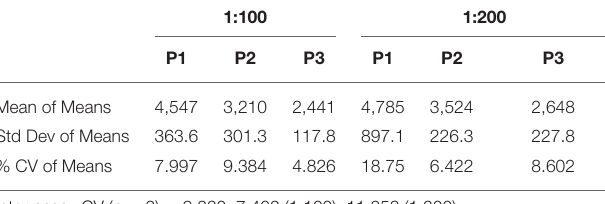
FIGURE 2 | Specificity of the C3(H 2 O) ELISA. (A) Binding comparison of proteins using anti-C3 pAb for detection . (B) Specificity of ELISA employing anti-C3a pAb. C3(MA) and iC3(MA) are detected. (C) Schematic depicting the cleavage and inactivation of C3(H 2 O) by cofactor proteins and the serine protease FI. Adapted from Elvington et al. ( 20). (D) Increasing concentrations of C3(MA) were spiked into 1:100 NHS which had a baseline C3(H 2 O) level of 938ng/ml and protein recovery of the C3(MA) over baseline was assessed by ELISA; n = 2, representative of 2 independent experiments. (E) C3(H 2 O) was measured in human serum and plasma from healthy adults; n = 3 donors (in duplicate, intra-assay precision; %CV 4.97). (F) Increasing quantity of purified C3b (red) or iC3b (blue) was incubated with 40ng/ml C3(MA) to assess if they compete for binding; n = 3. TABLE 1 | Inter-assay